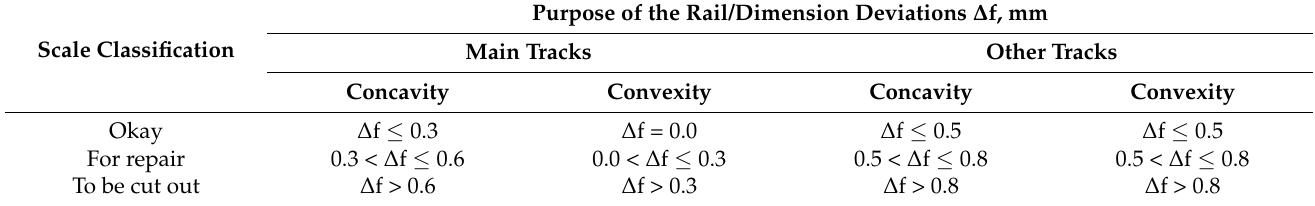
Table 4. Permissible deviations of horizontal